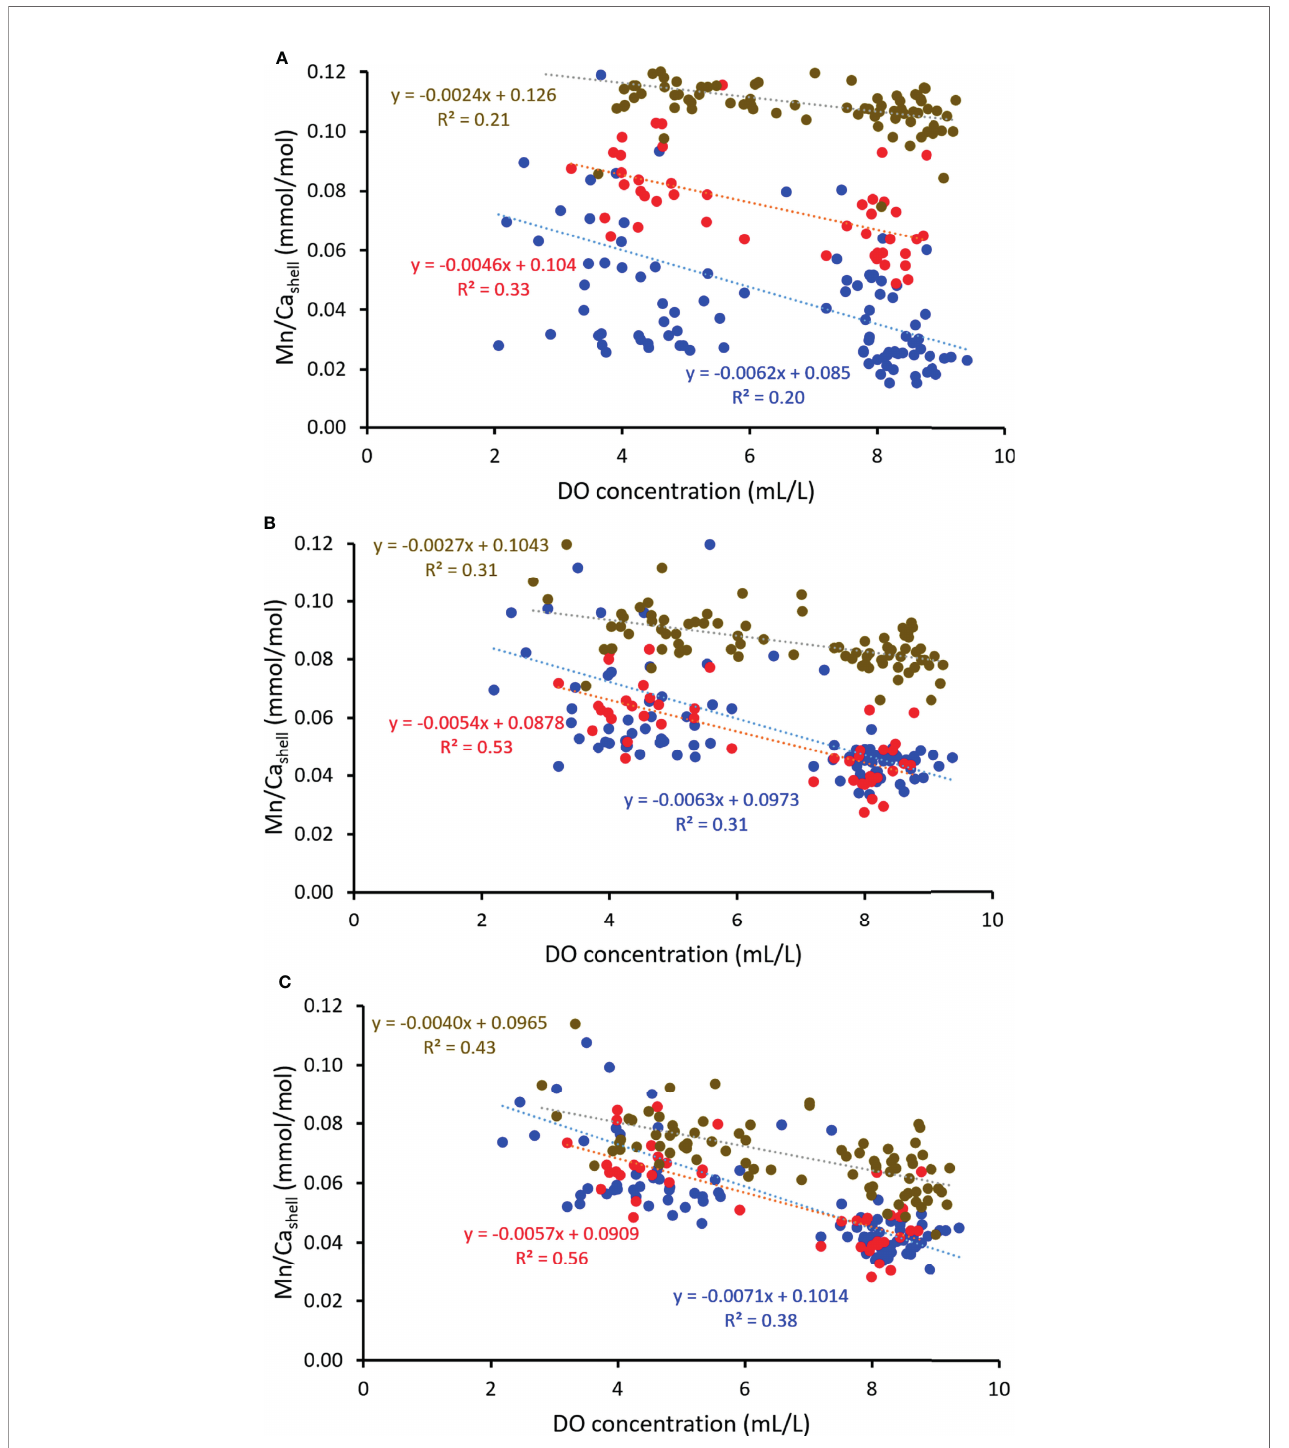
FIGURE 10 | Effect of different detrending techniques on the linear relationship between Mn/Ca shell of bivalves dwelling at sea fl oor and DO concentration measured some decimeters above sea fl oor. All correlations were highly signi fi cant at p < 0.0001. (A) Ontogenetic age trends removed; (B) Annual growth rate-detrended and (C) double detrended data, i.e., correlation between Mn/Ca shell with annual growth rate and Mg/Ca shell mathematically eliminated. Blue = A. islandica ; red = A. elliptica ; brown = A. borealis